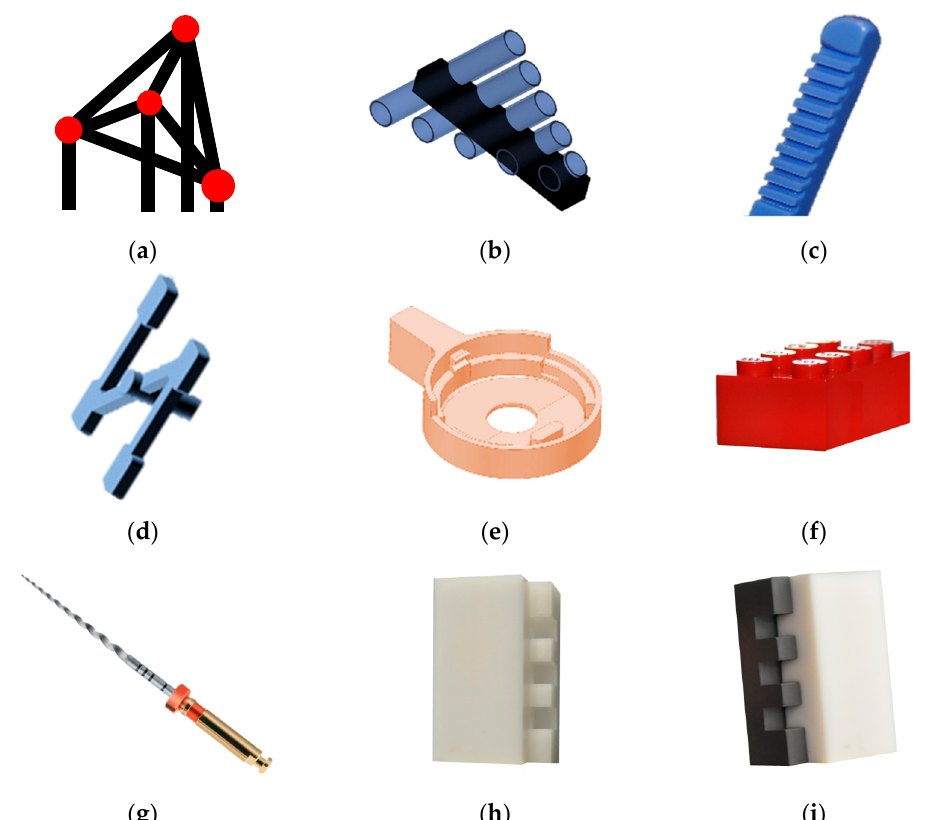
Figure 4. Work pieces: ( a ) CT Tetrahedron, ( b ) Pan Flute, ( c ) Step Gauge, ( d ) Dog bone, ( e ) Toggle, ( f ) Lego, ( g ) Endodontic file, ( h ) Multi-material TEF-POM, and ( i ) Multi-material TEF-PVC.